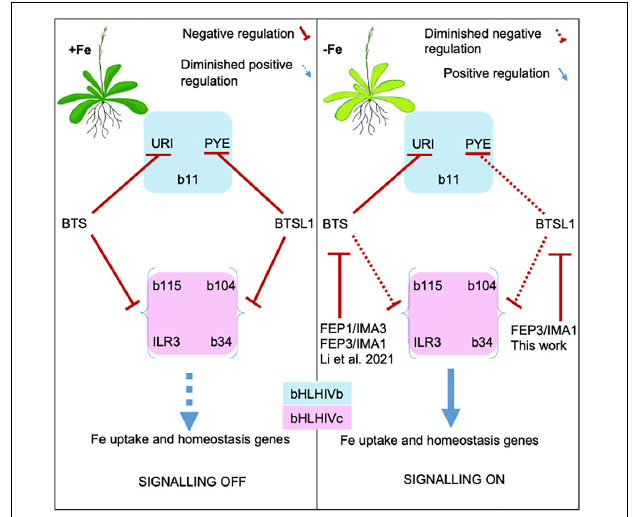
FIGURE 8 | Model of FEP1/IMA3 and FEP3/IMA1 action to prevent BTS and BTSL1 protein-mediated degradation of bHLH factors of subgroups IVb and IVc. bHLH subgroup IVb and IVc TFs elicit Fe uptake and homeostasis in response to –Fe. These TFs are targets of E3 ligases BTS and BTSL1, possibly through degradation. BTS and BTSL1 target the same bHLH IVc but different bHLH IVb proteins. BTS, BTSL1, and the small effector proteins FEP1 and FEP3 are induced upon –Fe downstream of the bHLH IVc TFs. BTS and BTSL1 receive FEP1/FEP3 signals similar to receptor-ligand interactions. Binding of FEP1/FEP3 attenuates BTS/BTSL1-mediated degradation of bHLH TFs of subgroups IVb and IVc, allowing for enhanced Fe deficiency responses. Later, increased degradation of bHLH factors may halt Fe uptake. This model is based on intricate balancing of BTS/BTSL1-TF interaction strength and FEP1/FEP3 availability, allowing the cell to rapidly switch between on/off states to adjust Fe uptake and homeostasis. BTSL1-bHLH-FEP3/IMA1 interaction was shown in this work. BTSL2 interacts with FEP3/IMA1 and with similar TF proteins of the subgroup IVb and IVc as BTSL1, and may have